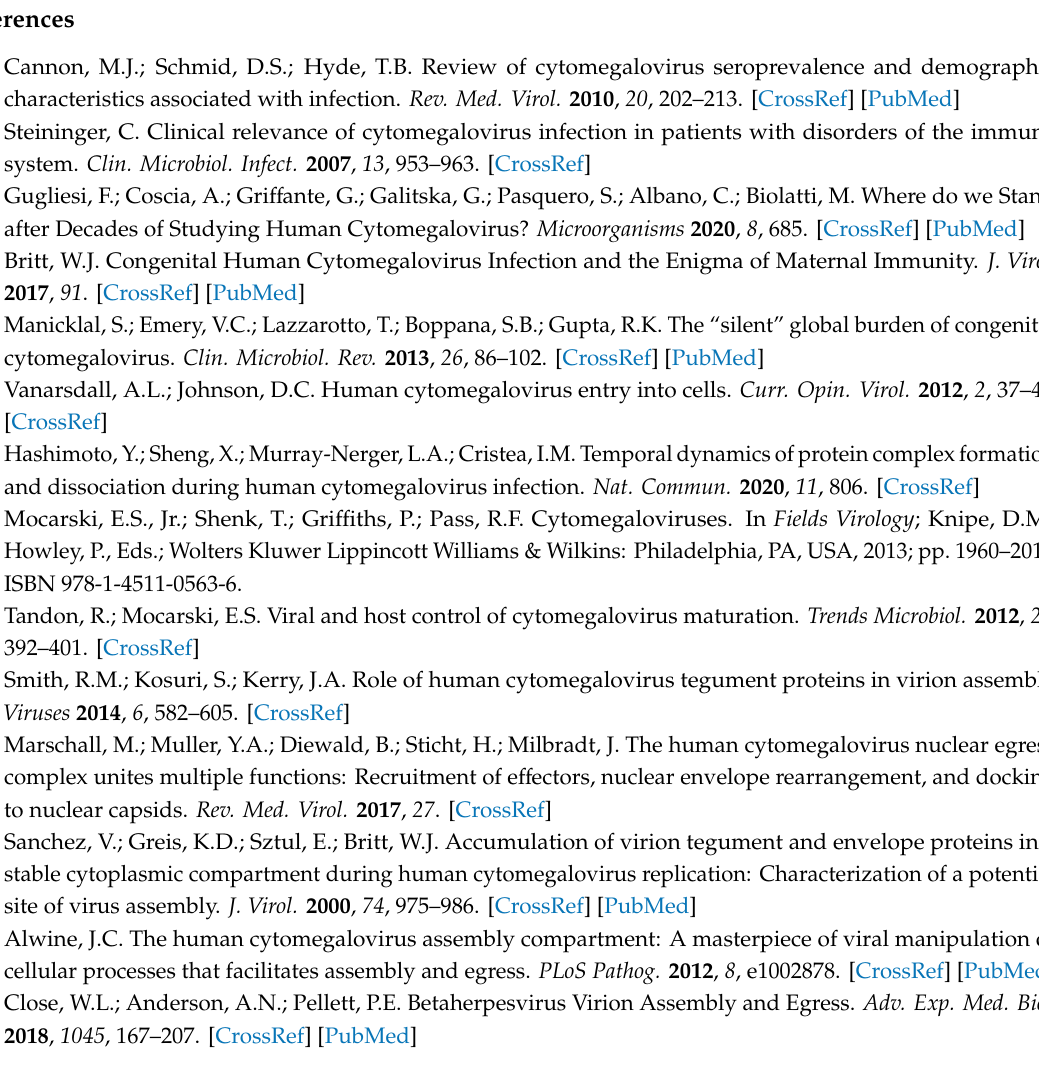
Table S1: Viral proteins identified by MS-based proteomics in HCMV virions. Table S2: Host proteins identified by MS-based proteomics in HCMV virions. Table S3: Phosphosites identified in viral proteins from purified HCMV virions. Table S4: Phosphosites identified in host proteins from purified HCMV